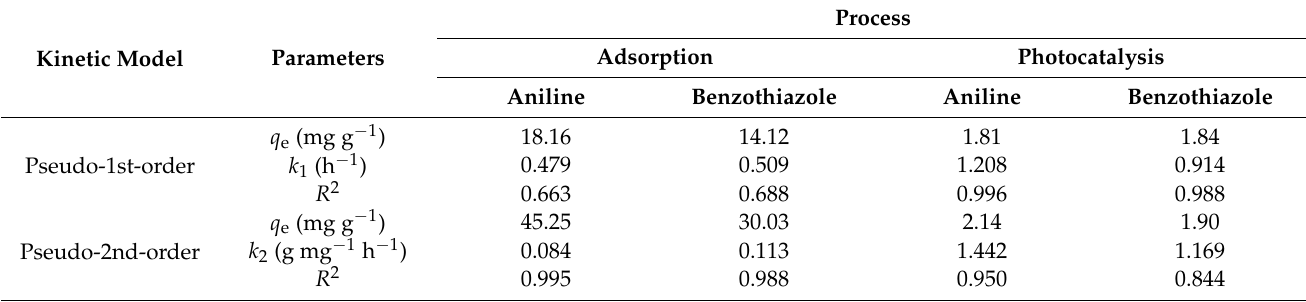
Table 4. Results from the kinetic modelling of the photocatalysis and adsorption process during ANI and BTH removal using the photocatalyst MnO 2 /GAC-3. Experimental conditions: C 0 = 12.0 mg L − 1 ; pH = 9.0; m CAT = 0.9 g L − 1 ; Irradiation dose = 155.8 W m − 2